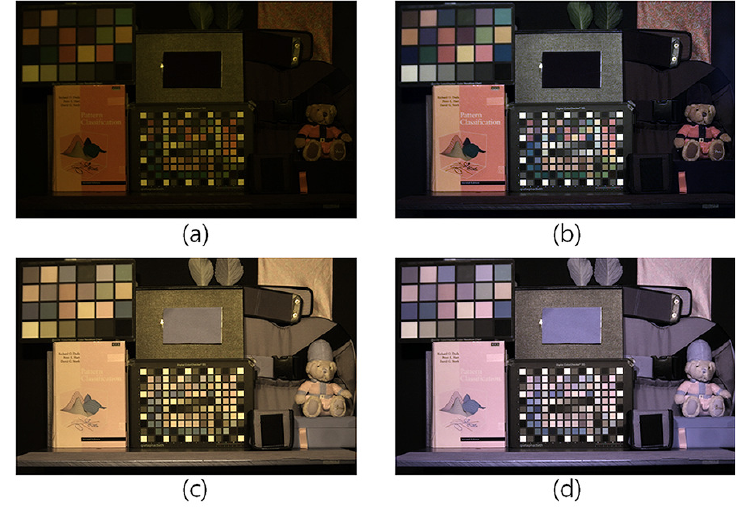
Figure 6. Color observation of the MSFA image sensor under incandescent light. ( a ) Image captured with IRCF; ( b ) (a) with white balance; ( c ) image captured with IRCF removal MSFA image sensor; ( d ) (c) with white